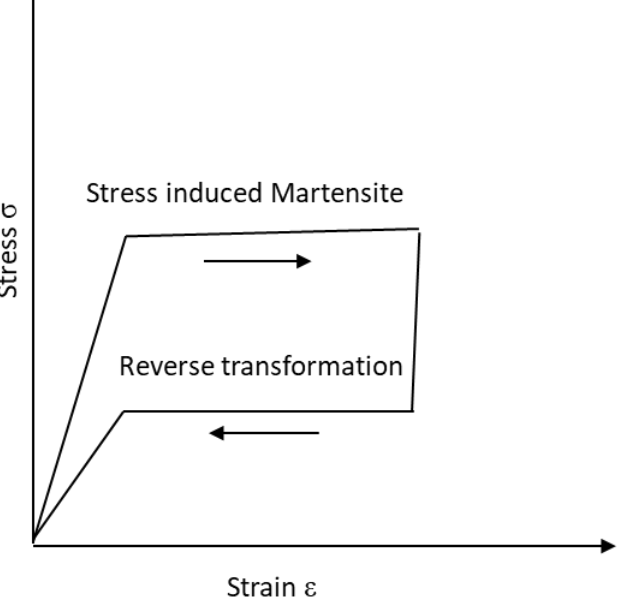
Figure 1. Reversible transformation from austenite to stress-induced martensite phase of superelastic SMA at test temperature > A f , showing energy hysteresis.